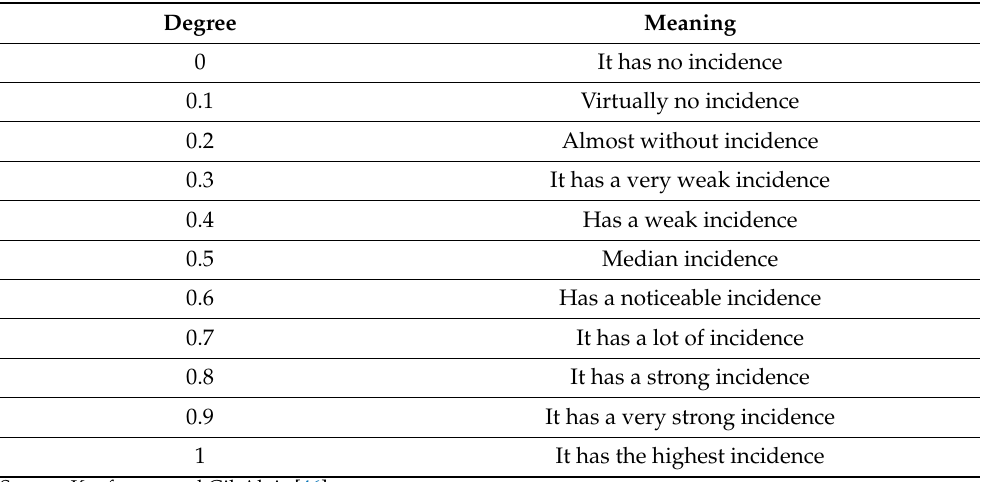
Table 3. Endecadary